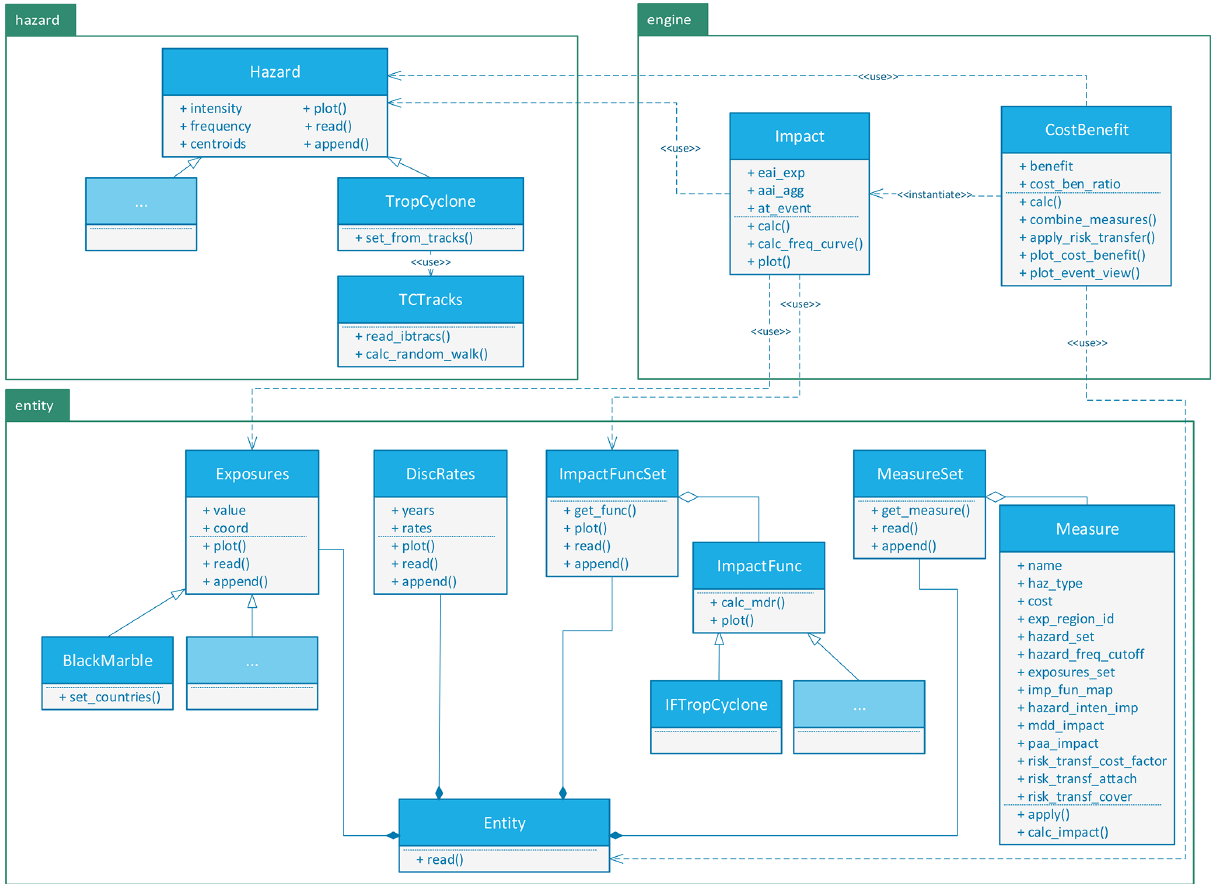
Figure 1. Simplified architecture of CLIMADA including classes for adaptation measures, discount rates, and cost–benefit considerations. An extension of Aznar-Siguan and Bresch